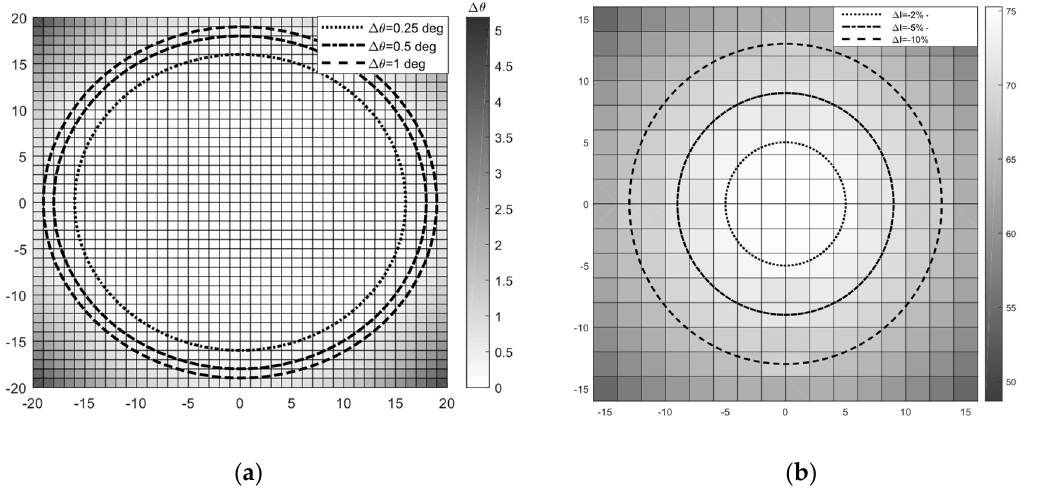
Figure 11. Measured spatial characteristics of the Sun simulator beam. ( a ) Divergence; ( b ) intensity uniformity [50].